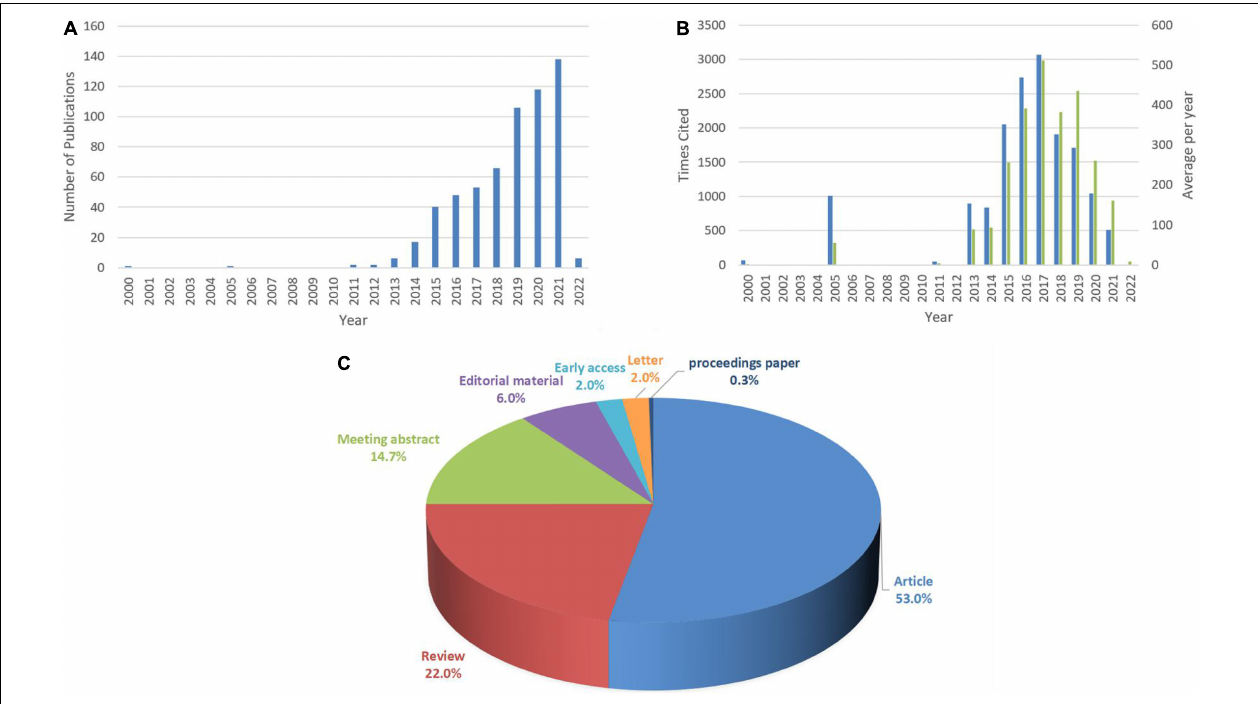
FIGURE 1 | Annual number, Times Cited frequency, average per year citation frequency and document type of ARNI publications in cardiovascular system research. (A) Annual distribution of the number. (B) Blue represents Times Cited and green for average per year frequency of citations. (C) Type of